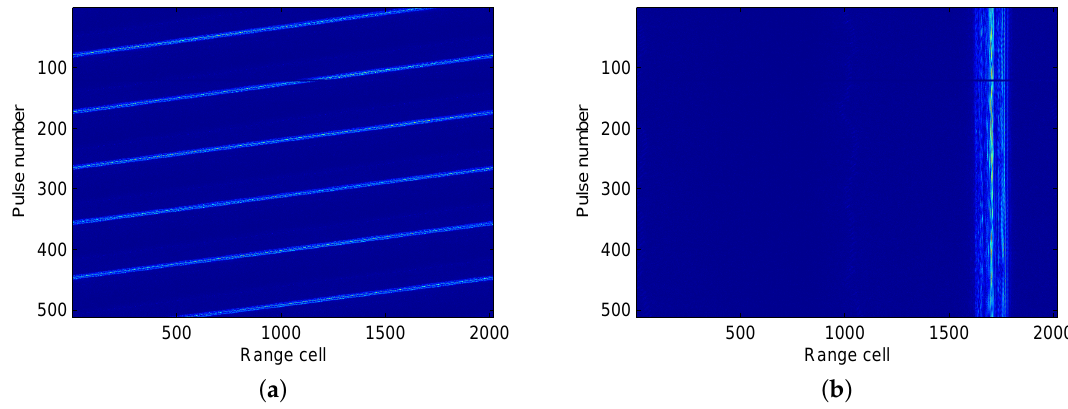
Figure 12. The range profiles of the target. ( a ) The range profiles with the range migration (RM) effect. ( b ) The range profiles after range alignment by the proposed CCAE method.